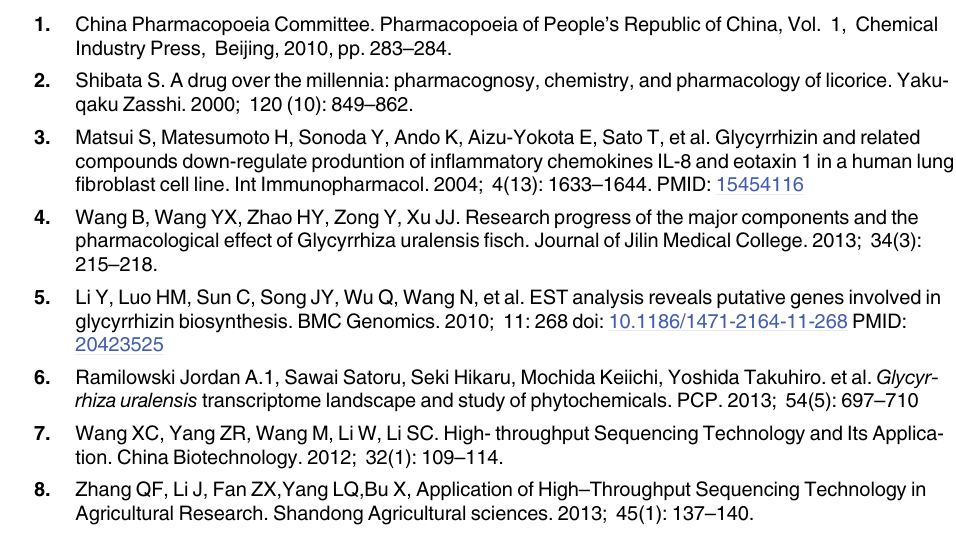
S1 Table. Sequences of 69 primer pairs for SSR